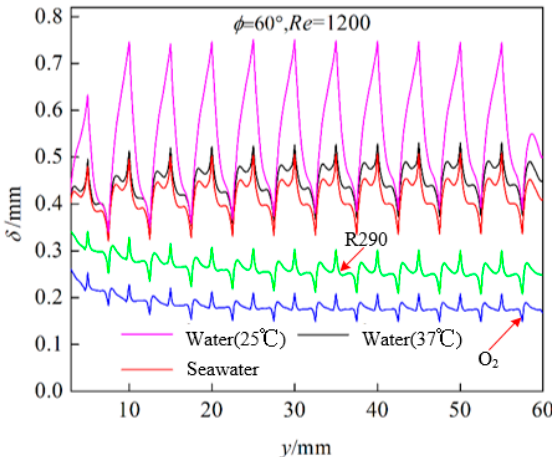
Figure 7. Local film thickness δ for different fluids.